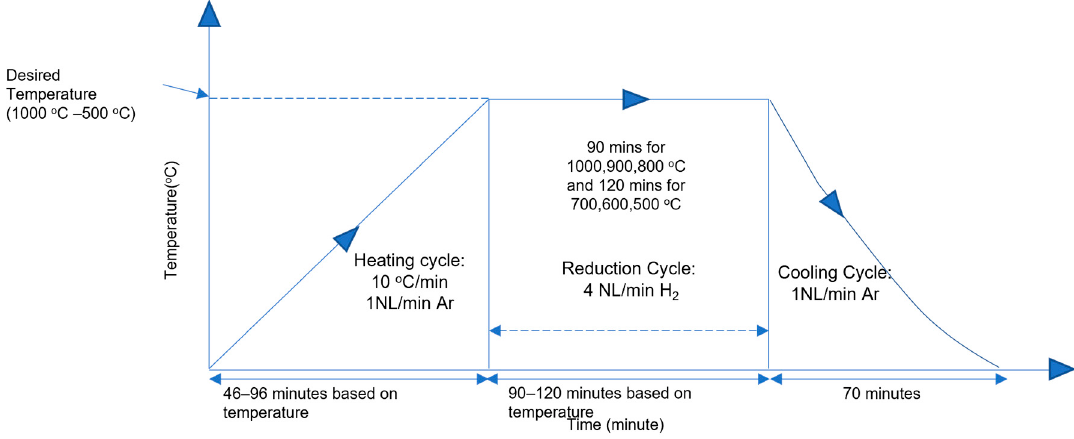
Figure 1. Heating profile of reduction experiments.